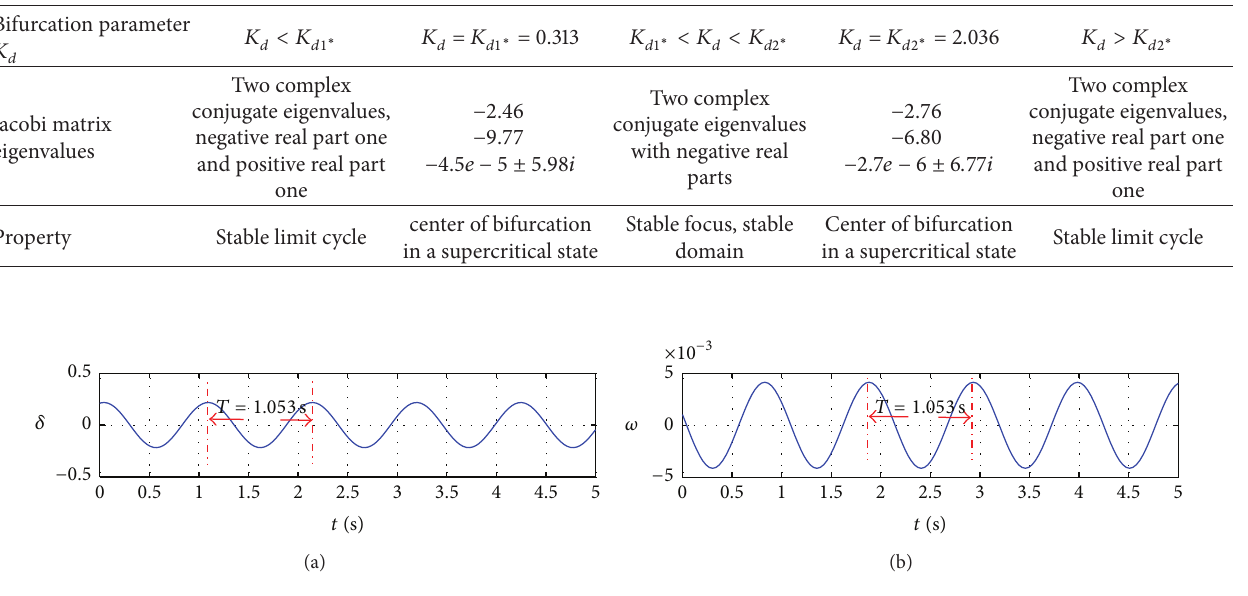
Table 1: Changes of system properties with the bifurcation parameter 𝐾 𝑑 .